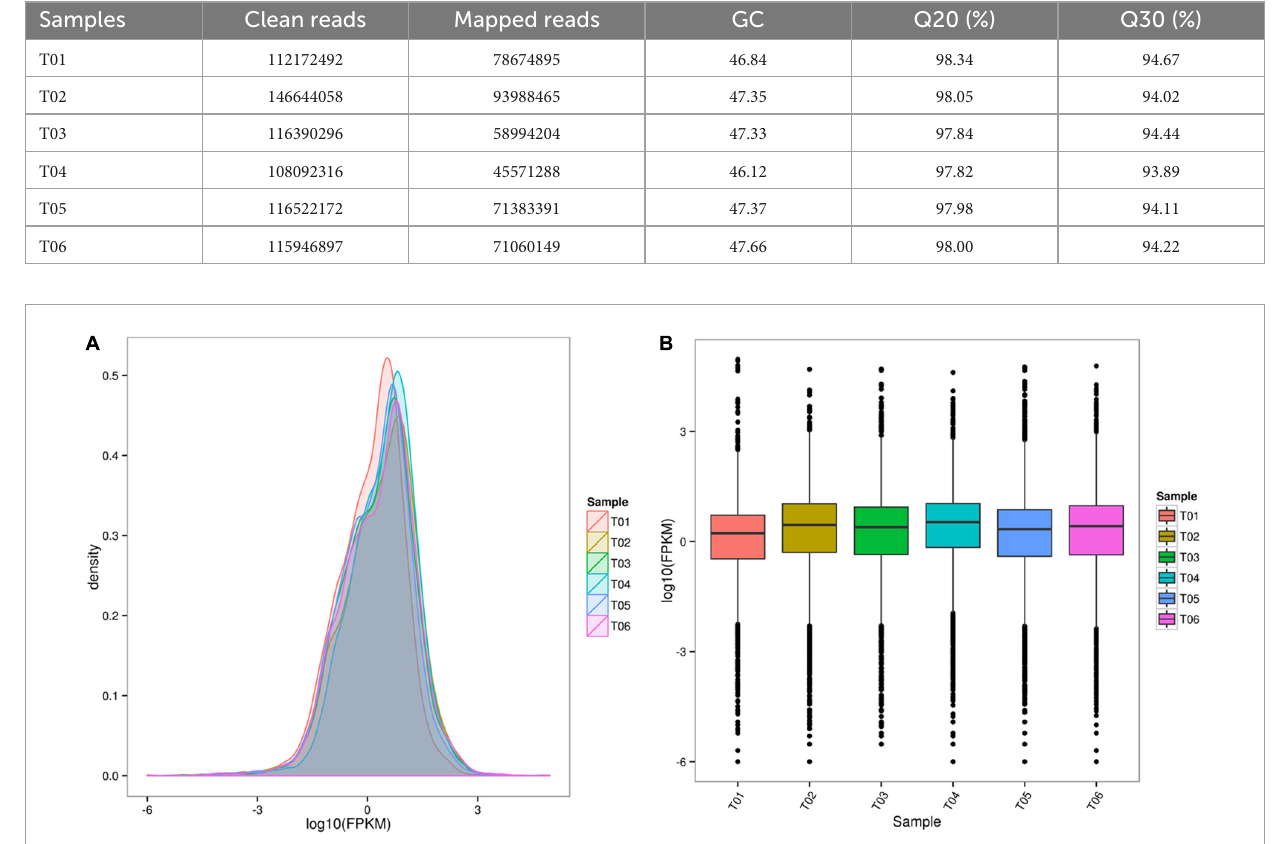
FIGURE1 RNA-seq data analysis. (A) Comparison of the fragments per kilobase of exon model per million (FPKM) density distribution for all samples. (B) Box-whisker plot of FPKM values for all samples.